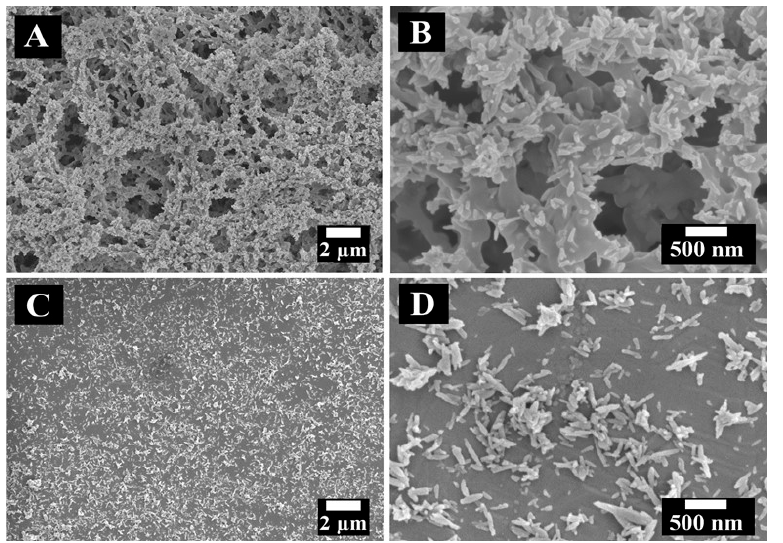
Figure 4. SEM micrographs at different magnifications for films prepared from 10 gL − 1 PEMA solutions in ethanol, containing 3 gL − 1 LA and 3 gL − 1 hydroxyapatite: ( A , B ) as deposited ( C , D ) annealed at 180 °C for one hour.